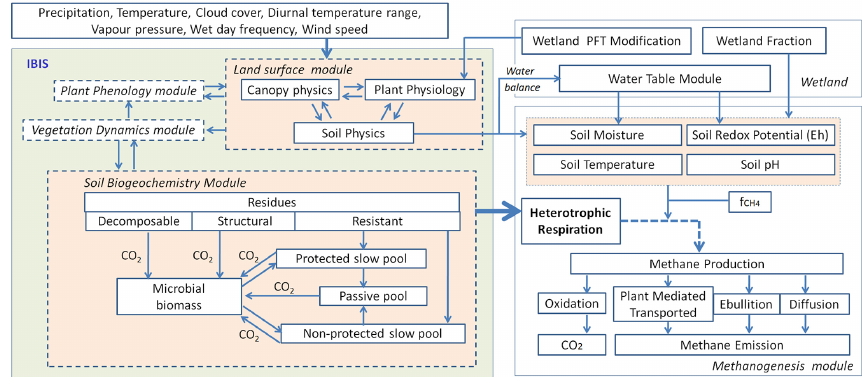
Figure 1. Basic structural concept and integration of CH 4 emission and the water table modules into DGVM of IBIS in